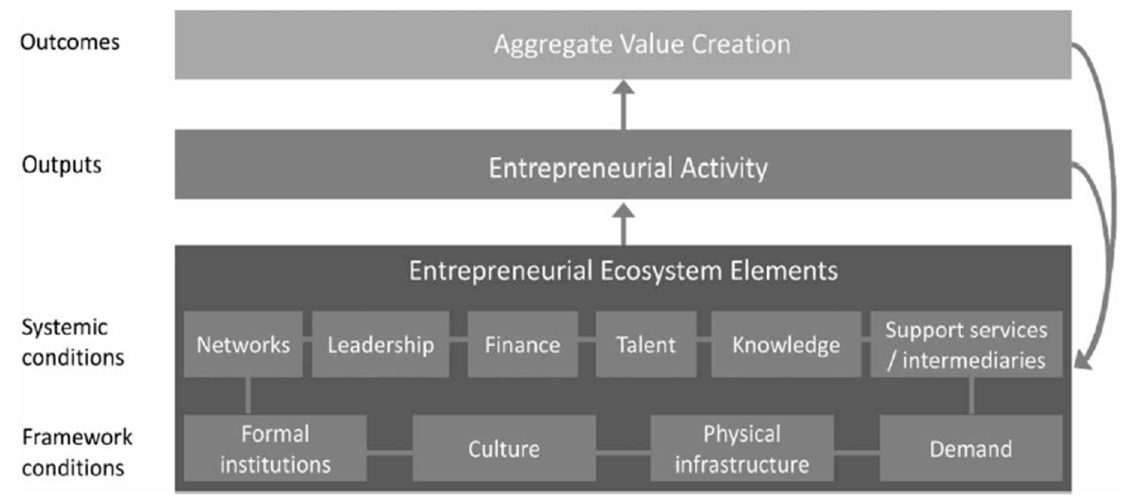
Figure 1. Entrepreneurial Ecosystem model. Source: ([7], p. 1765).